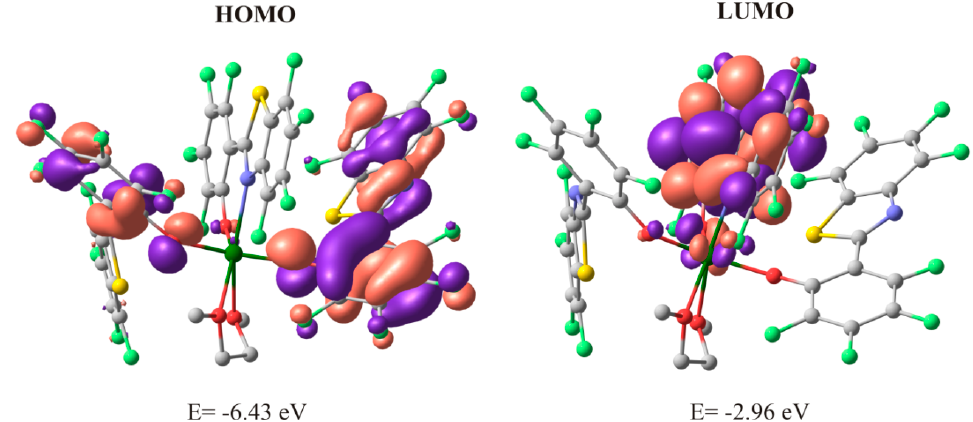
Figure 10. The shapes of HOMO and LUMO for complex 2 calculated by the DFT B3LYP/def2svp method (cutoff = 0.03 e/Å 3 ).